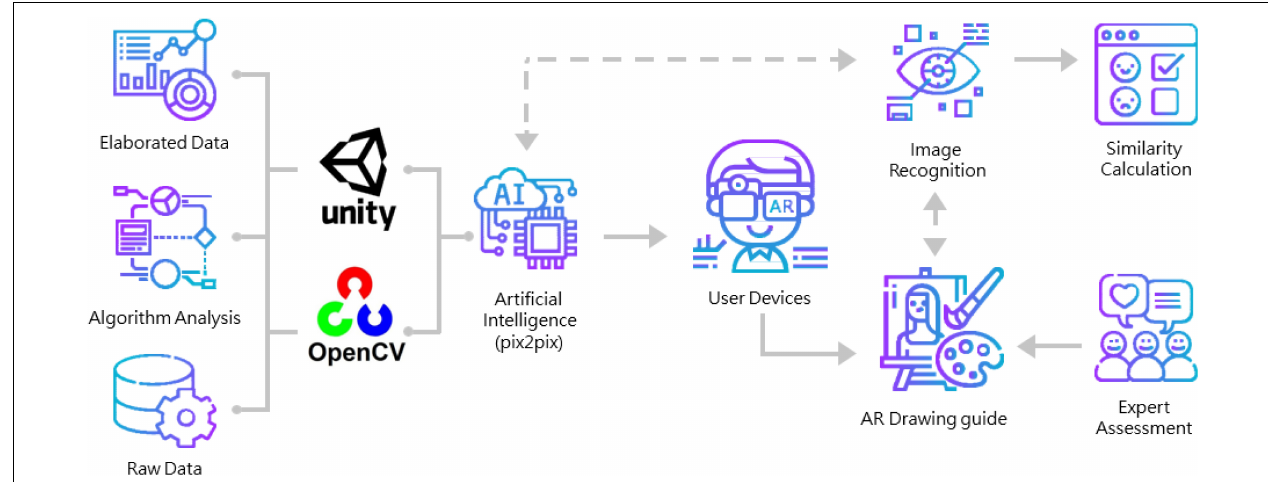
FIGURE 1 | System architecture diagram of children’s digital art ability training system based on AI-assisted learning.